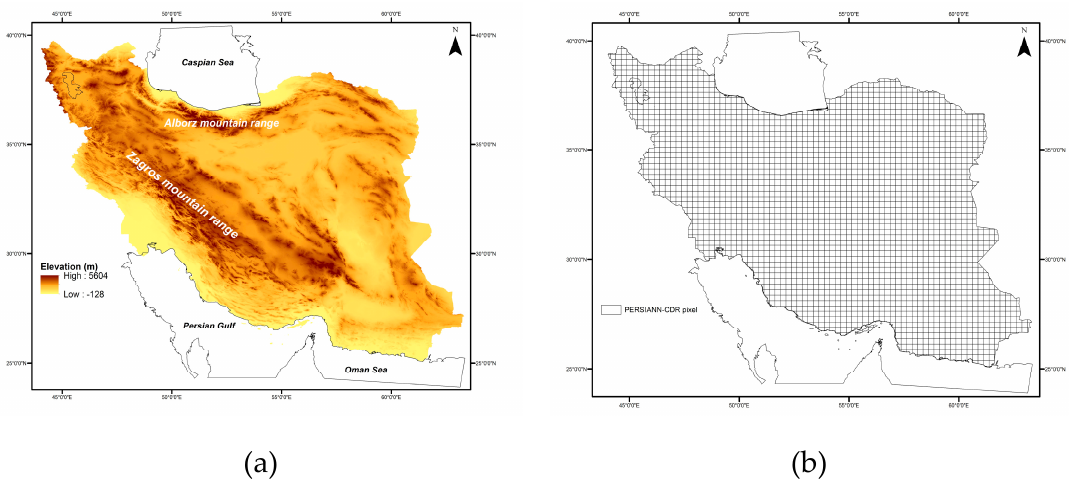
Figure 1. ( a ) Topographic map of Iran; ( b ) grid pixels of Precipitation Estimation from Remotely Sensed Information using Artificial Neural Networks-Climate Data Record (PERSIANN-CDR).